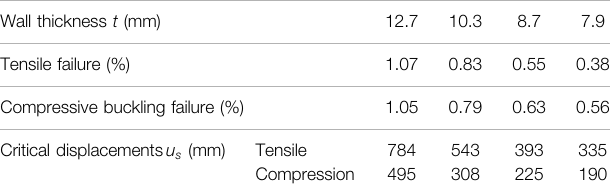
TABLE 1 | Critical displacements of the thawing landslide of soil under an ultimate